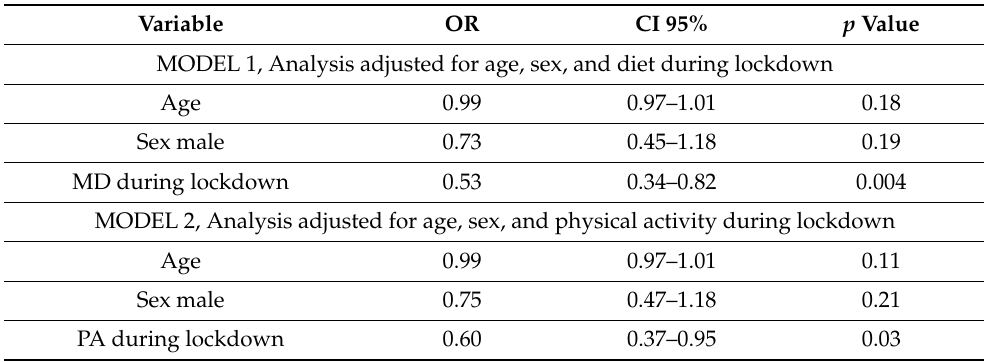
Table 2. Multivariate analysis of factors associated to weight gain in the entire